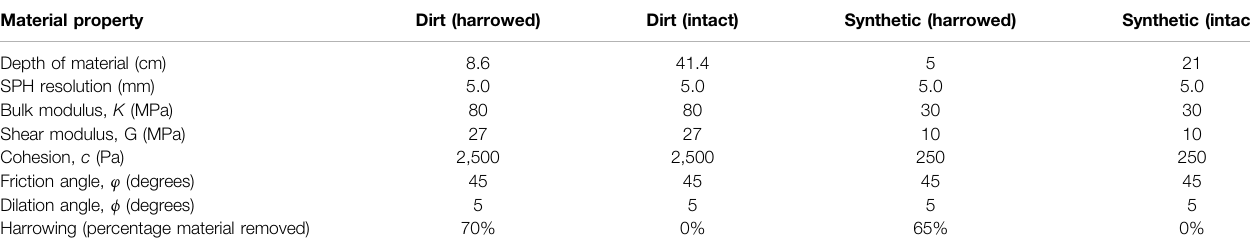
TABLE 1 | Calibrated elastic and D-P material parameters for the SPH model of each track material. Material